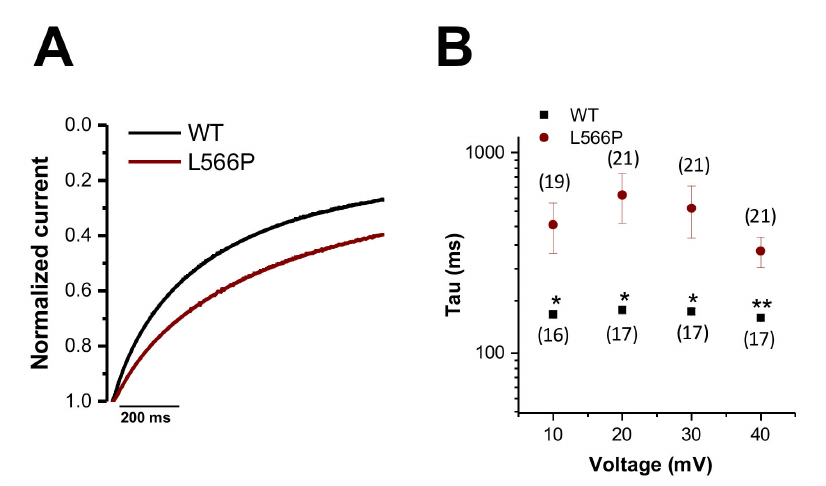
Figure 2. Kinetics of the voltage-dependent inactivation of Ca V 1.2 WT and Ca V 1.2 L566P . ( A ) Averaged Ca V 1.2 WT (black) and Ca V 1.2 L566P (red) current traces at +20 mV recorded from a holding potential of − 80 mV, with a voltage step of 1 s duration to +20 mV ( n = 17 and n = 21, respectively). ( B ) Time constants of inactivation for Ca V 1.2 WT (black) ( n = 16–17) or Ca V 1.2 L566P (red) ( n = 19–21) at different potentials for the first 200 ms of inactivation derived by a mono-exponential fit. **, p < 0.01; *, p <